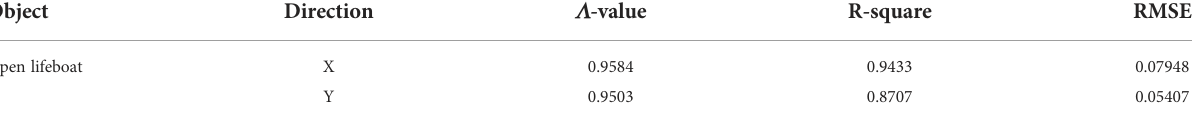
TABLE 4 Linear regression results of dynamic model coef fi